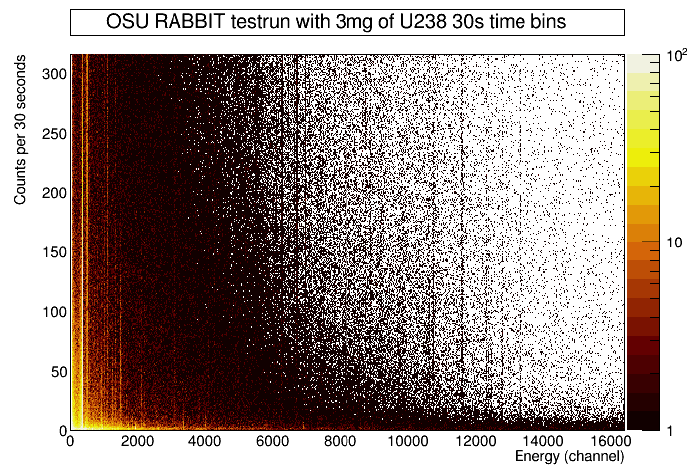
Figure 4. Test irradiation of U238 in the OSU TRIGA